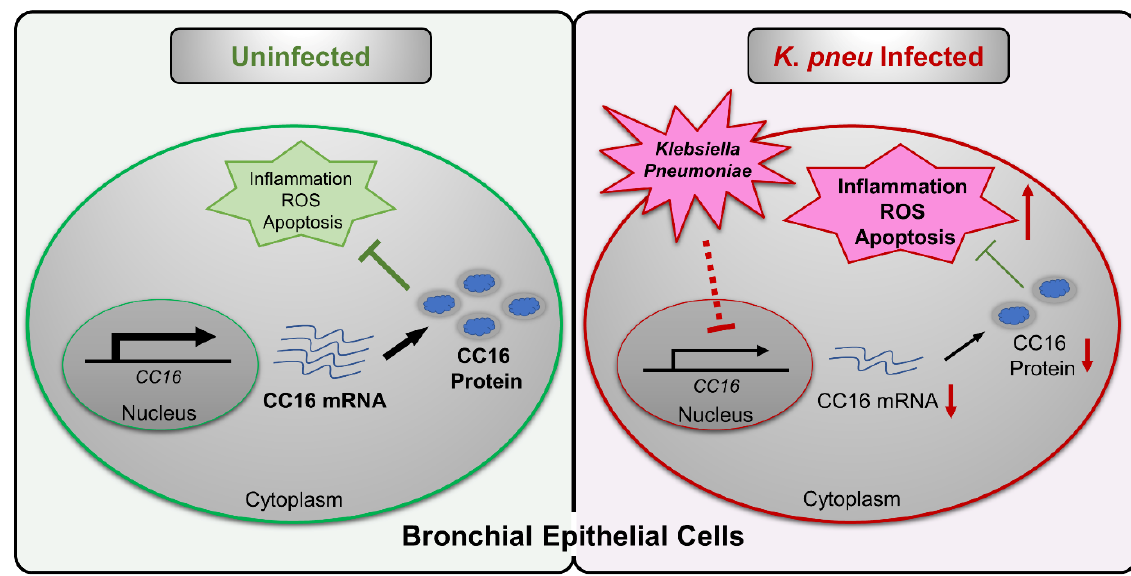
Figure 5. Schematic review of the regulation and function of CC16 in bronchial epithelial cells during K. pneu infection. K. pneu infection reduces CC16 expression in bronchial epithelial cells. The decreased CC16 level promotes K. pneu- induced inflammation, ROS, and apoptosis. Moreover, intracellular rather than extracellular CC16 has an anti-inflammatory effect in bronchial epithelial cells.